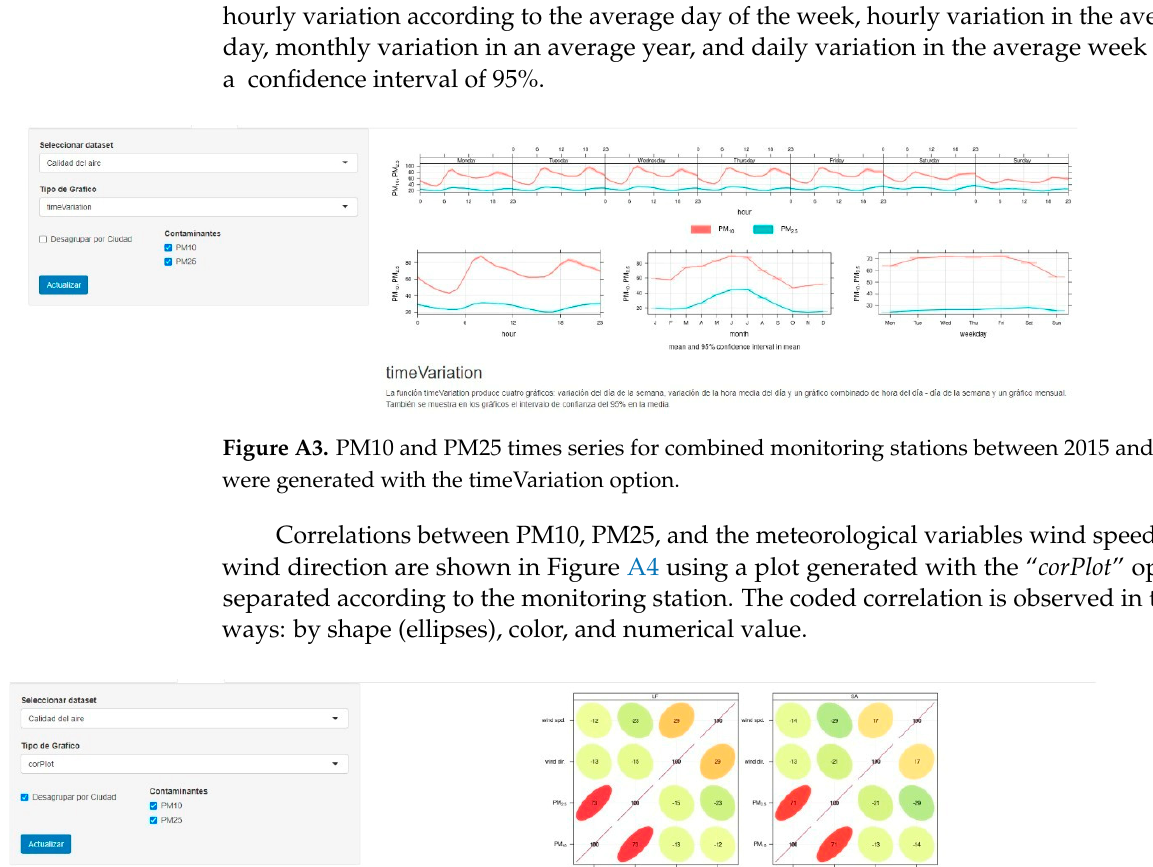
Figure A2. PM10 monthly time series for the monitoring stations La Florida (LF) and Parque O’Higgins (SA) between 2015 and 2020.